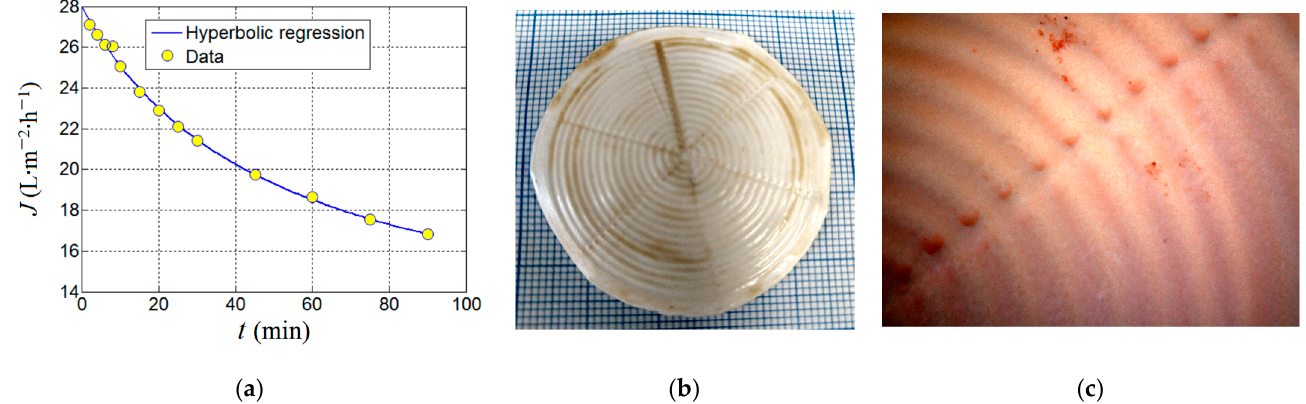
Figure 12. Outcomes of the ultrafiltration test performed by using PVDF-HFP/HS (3%) composite membrane: ( a ) permeate flux decline observed under optimal conditions ( SD = 0.674% w / v , pH 7.0); ( b ) photo image of the spent membrane at the end of UF test; ( c ) the microscopic image that shows the top surface of the spent membrane highlighting the deposition of the cake fragments (distinguished as brown spots).